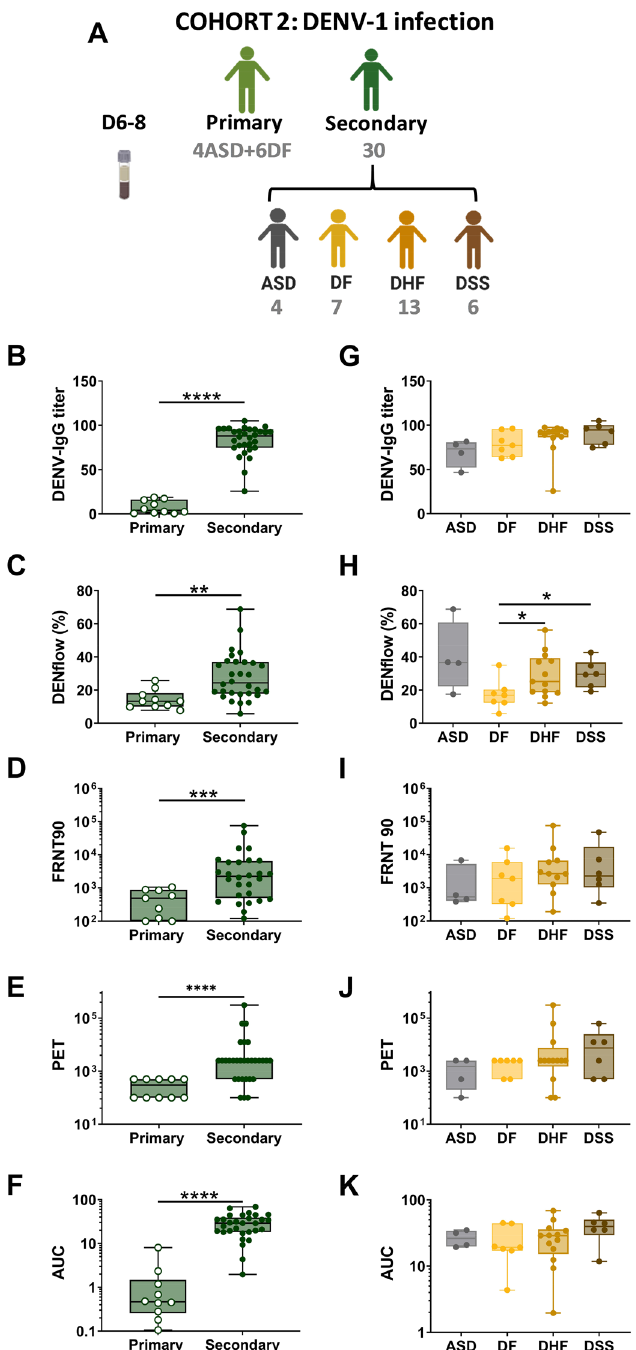
Figure 3. Comparison of anti-DENV antibody responses in infected individuals with different immune status and clinical outcome. Graphical summary of plasma samples collected in cohort 2 ( A ). Plasma samples were collected at day 6 to day 8 after the day after laboratory-confirmed infection. Plasma samples in cohort 2 were analyzed for DENV IgG titer ( B, G ), percentage of IgG binding to DENV-1-infected cells (DENflow) ( C, H ), neutralizing antibodies (FRNT90) to DENV-1 ( D, I ) and ADE activity to DENV-1 expressed as PET ( E, J ) and AUC ( F, K ). Each point in the box plot represents an individual plasma sample. Whiskers show max, min, median values and the interquartile range beyond the 25th and 75th percentiles. Mann–Whitney test was used to compare groups. (* P < 0.05; ** P < 0.01; *** P < 0.001; **** P <